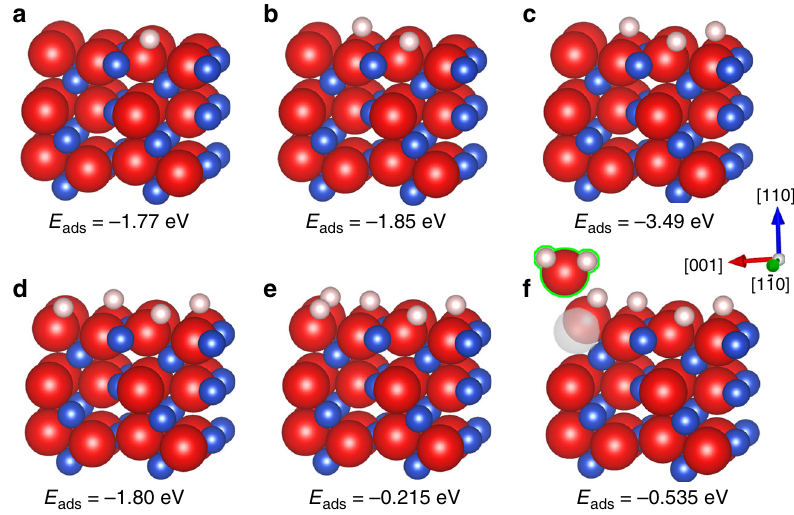
Fig. 6 DFT modeling of H 2 O formation on CuO. a – e Minimum-energy structures of the CuO ð (cid:1) 220 Þ surface with the sequential adsorption of H atoms to form OH groups that remain stable at the surface. f Adsorption of the sixth H atom results in the formation of an H 2 O molecule that spontaneously desorbs from the surface, resulting in an oxygen vacancy at the surface. Blue, red, pink, and gray balls represent Cu, O, H, and O vacancy,